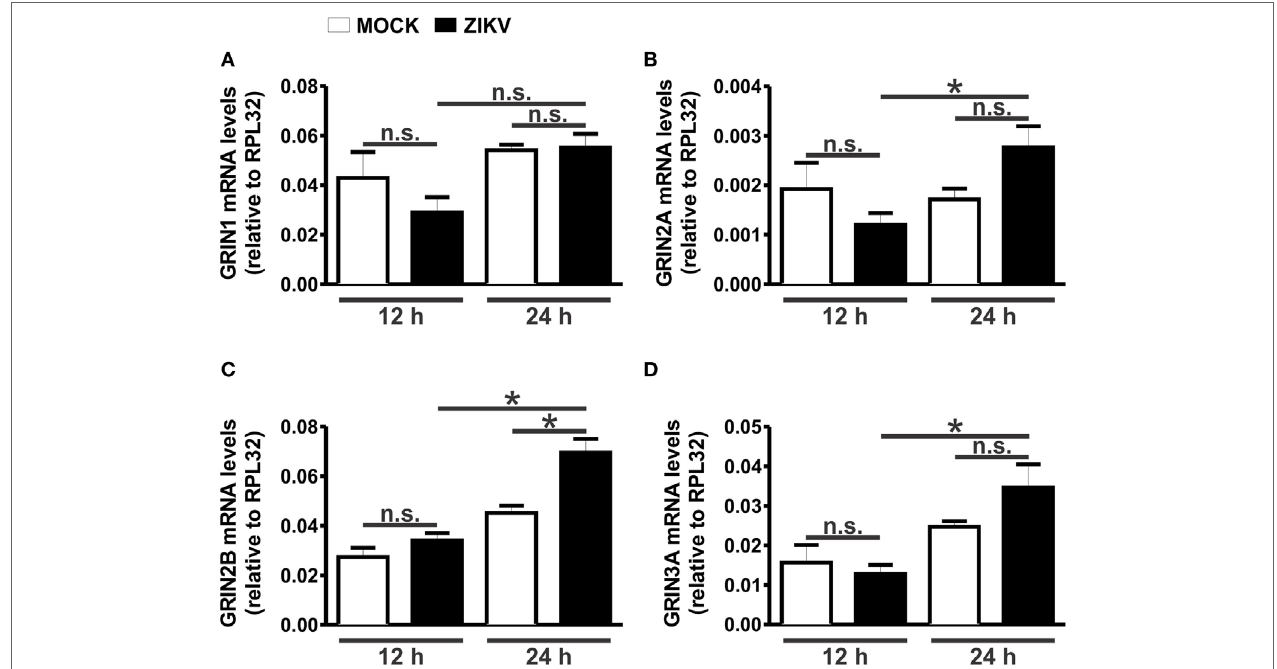
FigUre 3 | Zika virus (ZIKV) infection increases GluN2 expression. Graphs show mRNA levels of the N -methyl- d -aspartate receptor subunits, GluN1 (GRIN1) (a) , GluN2A (GRIN2A) (B) , GluN2B (GRIN2B) (c) , and GluN3A (GRIN3A) (D) , in primary cultured corticostriatal neurons, 12 and 24 h following MOCK or ZIKV infection. mRNA levels were assessed by quantitative RT-PCR, which was performed in triplicate and normalized to RPL32 mRNA levels. Data represent the means ± SEM, n = 6. n.s. indicates not significant and * indicates significant difference ( p <